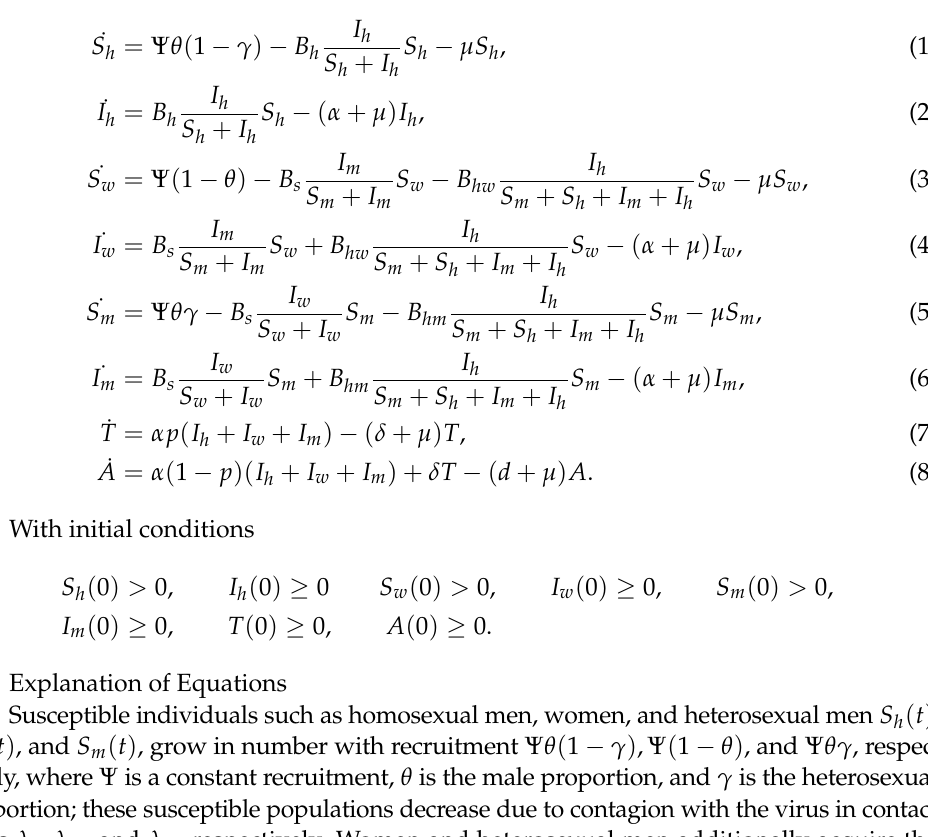
Figure 2. Model Diagram. Adapted from